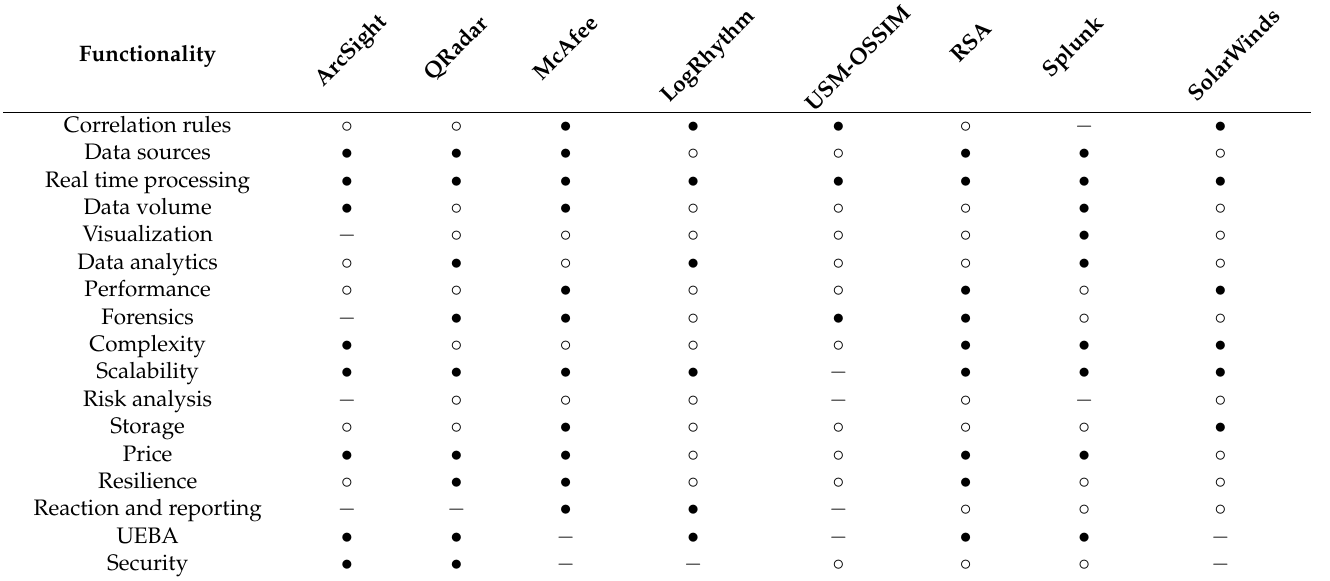
Table 3. Analysis of different SIEM